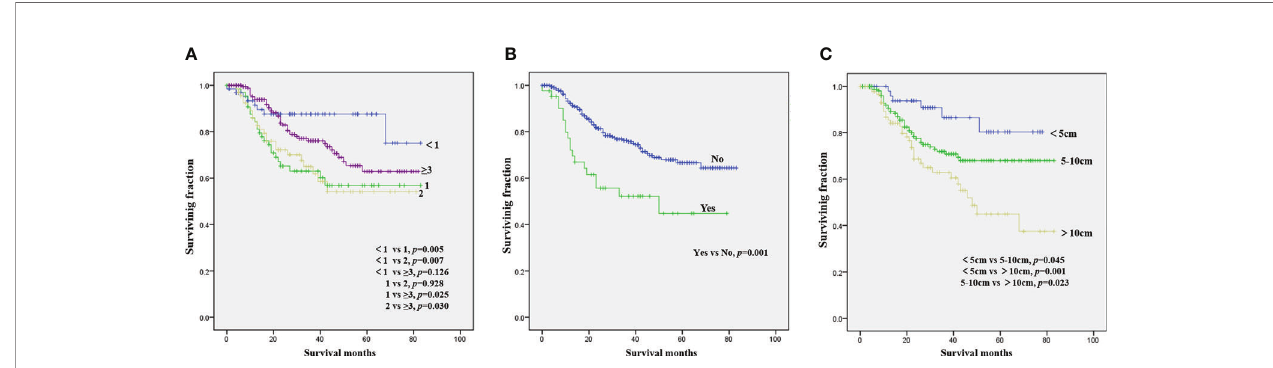
FIGURE 2 | Kaplan – Meier method for the estimation of CSS in NB patients with bone metastasis at diagnosis strati fi ed by age (A) , lung metastasis (B) , and tumor size (C) . NB, neuroblastoma; CSS, cancer-speci fi